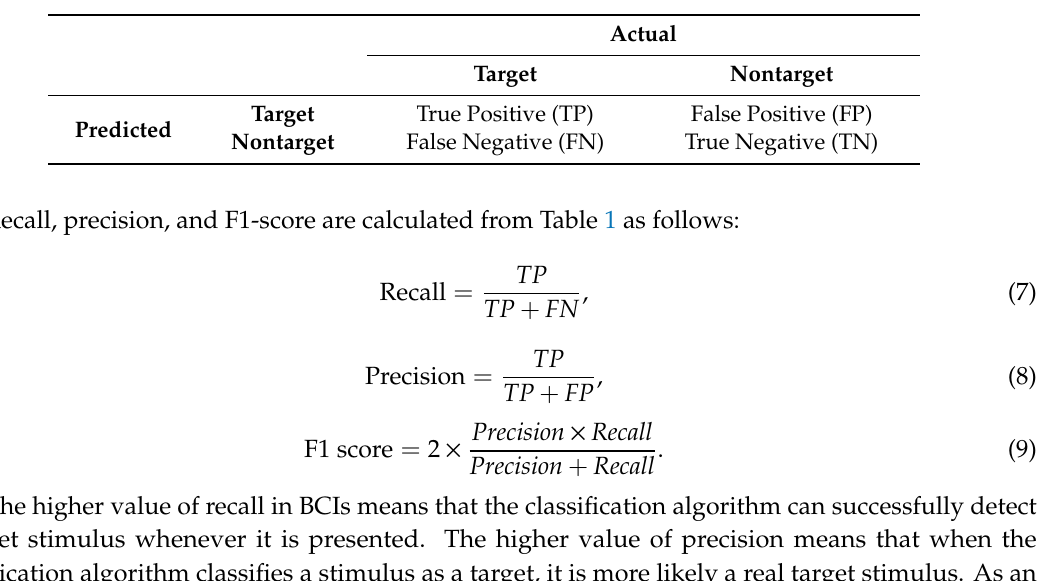
Table 1. Confusion